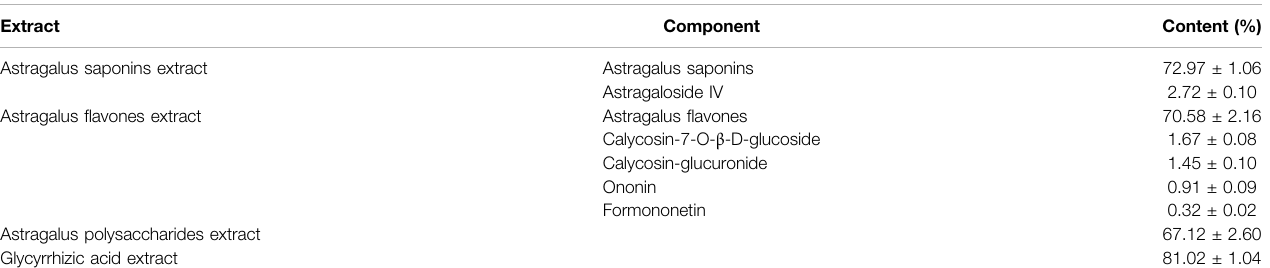
TABLE 1 | The content of each component (x±SD, n = 3). Extract Component Astragalus saponins